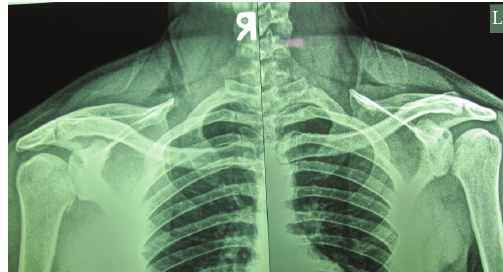
Figure 1: Anteroposterior X-ray shows bilateral posterior disloca- tion di ffi culty with absence of normal half-moon sign.